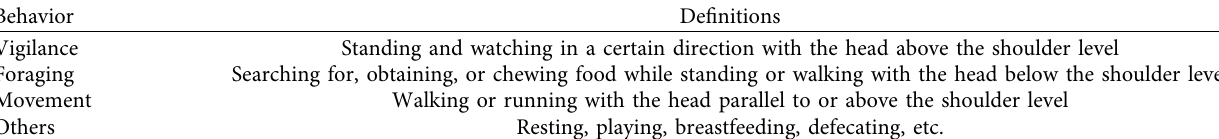
Table 1: Definitions of the behavioral variables used for Tibetan antelope in this study.